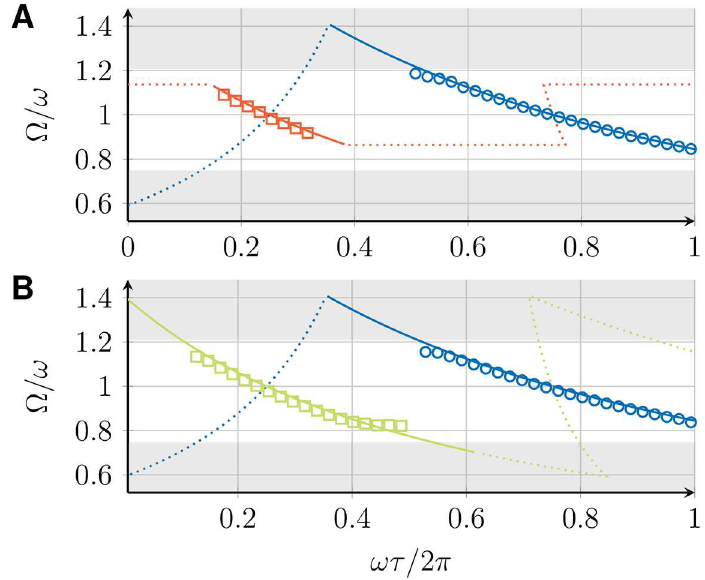
Fig 13. Experimental measurements of the collective frequencies Ω for nine coupled DPLLs. Collective frequency Ω of different synchronized states for a square lattice of 3 × 3 mutually coupledDPLLs as a function of the transmissiondelay τ . (A) In-phase synchronized state (blue circles) and all combinations of m 1 - m 2 -twist synchronized states with m 1 , m 2 6¼ 0 (red squares)for a system with periodicboundaryconditions. (B) In- phasesynchronizedstate (blue circles) and checkerboard synchronized state (green squares)for a system with open boundaryconditions. The shaded areas display the system’s clippingregionas shown in Fig 8. Color code as in Fig